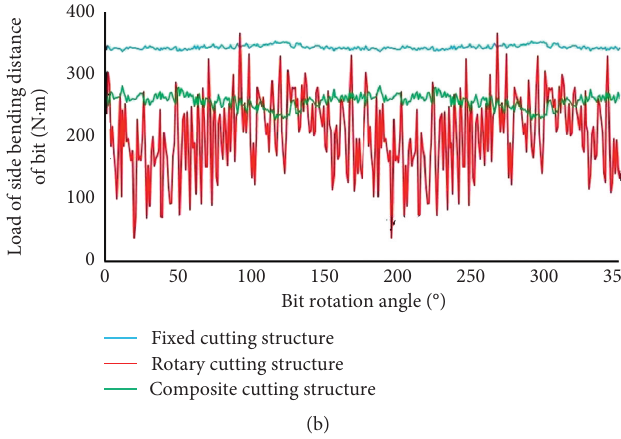
Figure 10: Comparison of the torque-side load of the bit torque. (a) The torque of bit. (b) The torque-side load of